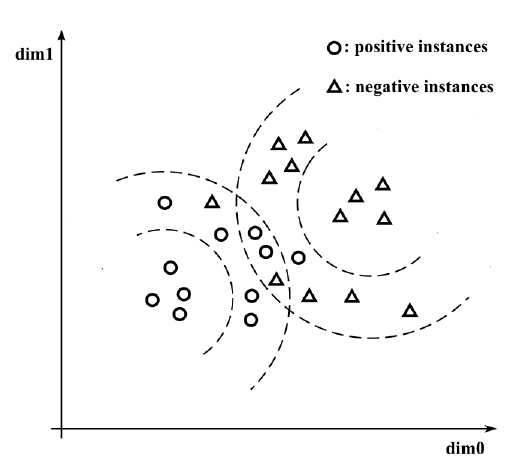
Figure 2. Illustrative example of artificial data in a two-dimensional case. Double annuluses are generated in the centers of positive instances and negative